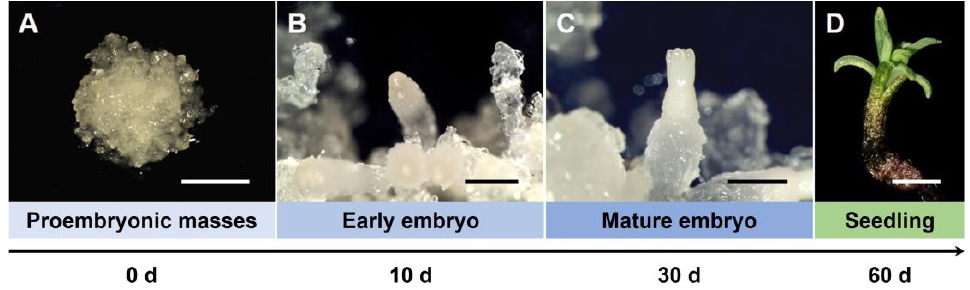
Figure 7. Characteristic stages of somatic development of T . koraiensis embryos and seedling. ( A ) Proembryonic masses (PEMs) on maturation medium. Scale bar: 5 mm. ( B ) Early embryo on maturation medium after 10 days. Scale bar: 1 mm. ( C ) Fully mature cotyledonary embryo on maturation medium after 30 days. Scale bar: 2 mm. ( D ) Somatic seedling with the first true needles emerging and a taproot on germination medium after 60 days. Scale bar: 1 mm.